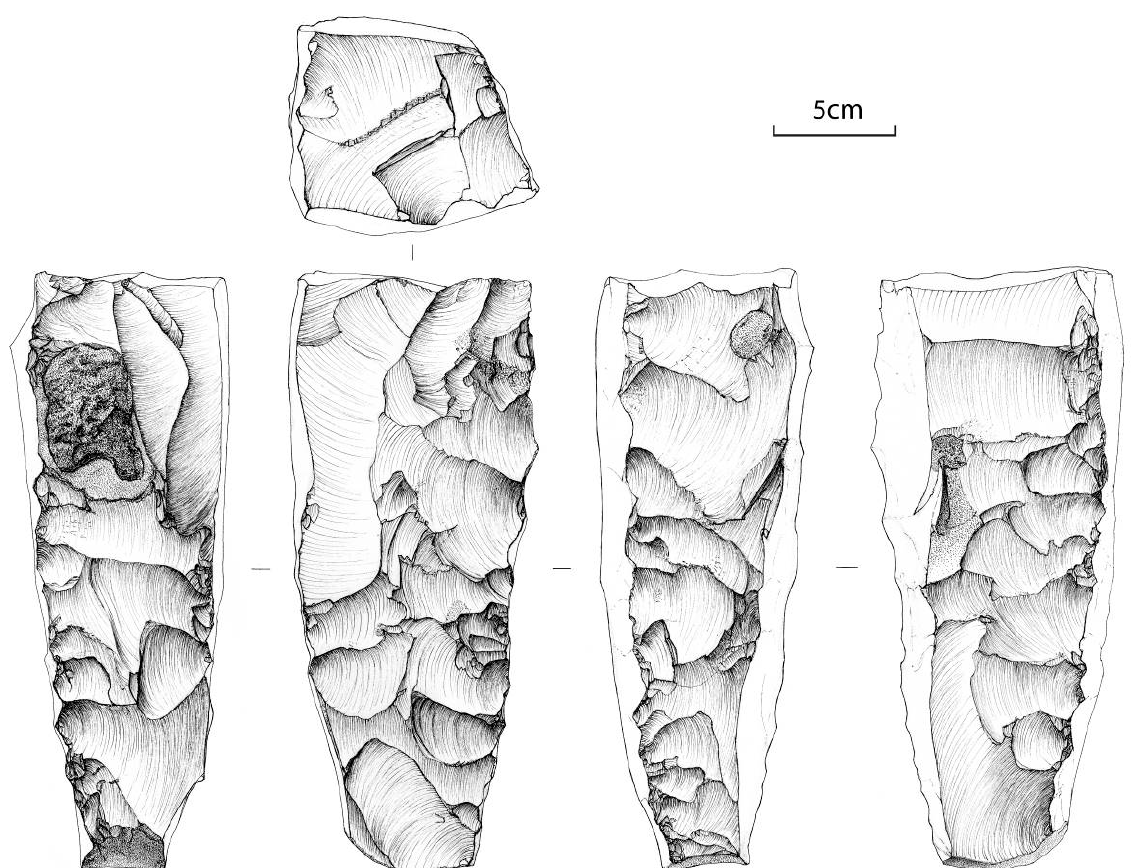
Figure 23. Spiennes, Camp-à-Cayaux. Blade core abandoned at the stage of shaping. L. Desailly Collection,